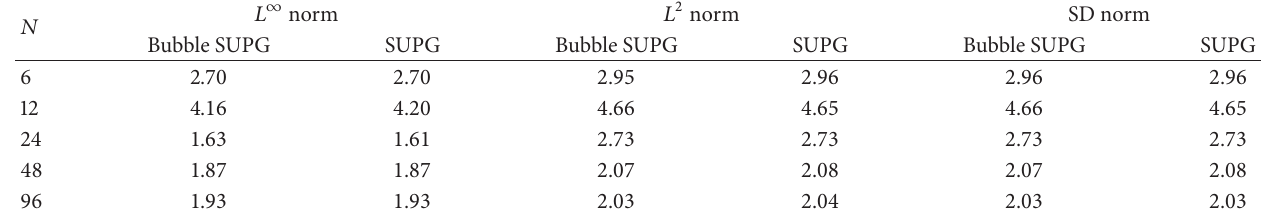
Table 2: 𝜀 = 10 −8 , Problem 1 (comparison of convergence rate).